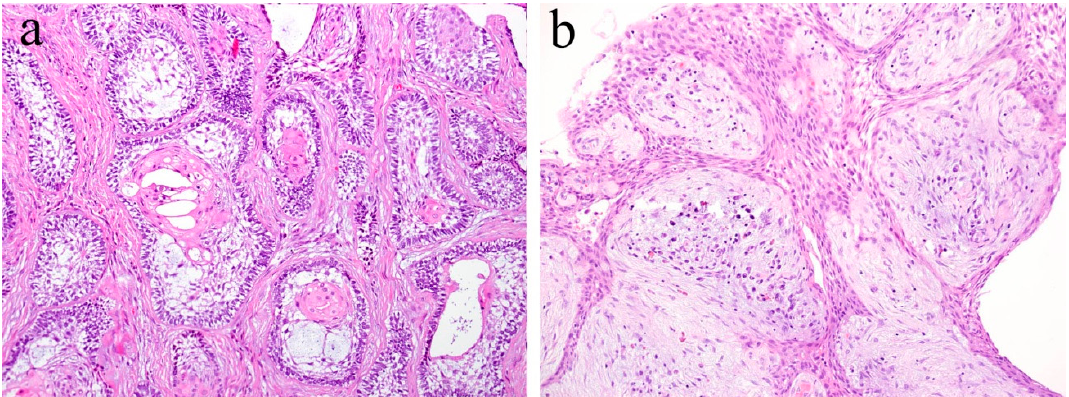
Figure 1. Histopathological features of ameloblastoma. The growth patterns of these tumors are classified as ( a ) follicular type and ( b ) plexiform type. HE staining, magnification ×